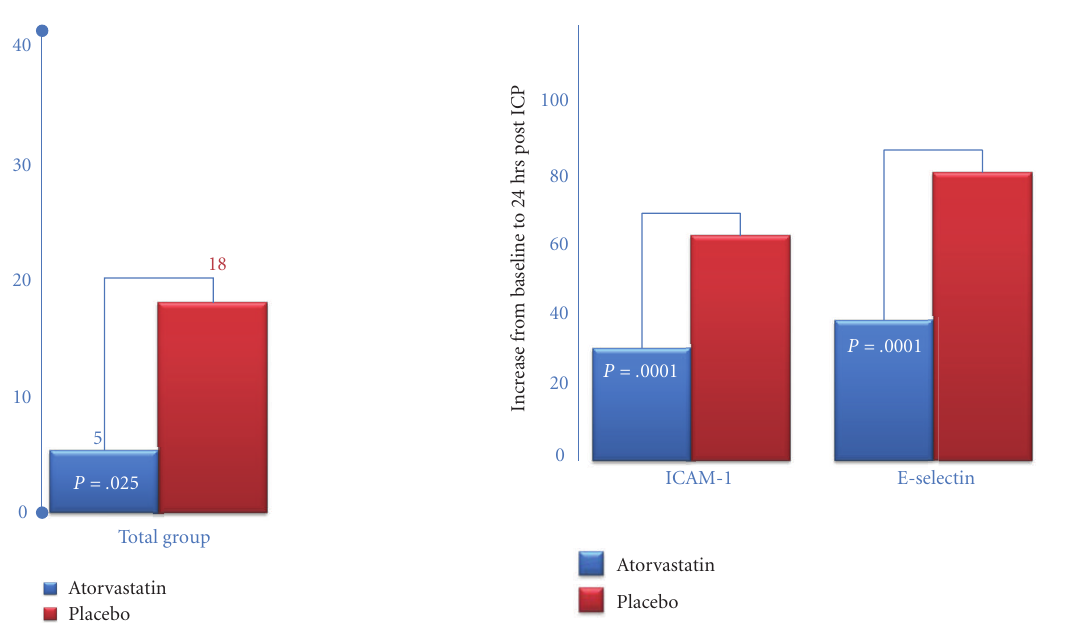
Figure 5: ARMYDA-Original study. This modified graphic of the ARMYDA-Original study (Vincenso Pasceri as first author) demonstrated for the first time as a randomized study the favorable e ff ect of statins before PCI. In individuals with stable coronary syn- dromes, statin-na¨ıve, undergoing elective PCI, the administration of atorvastatin 40mg/7 days before PCI significantly reduces the incidence of MI-PCI associated (CPK-MB > 2x ULN, 2004 criteria). The MI-PCI associated was 18% in the placebo group versus 5% in the atorvastatin group with P = . 025.